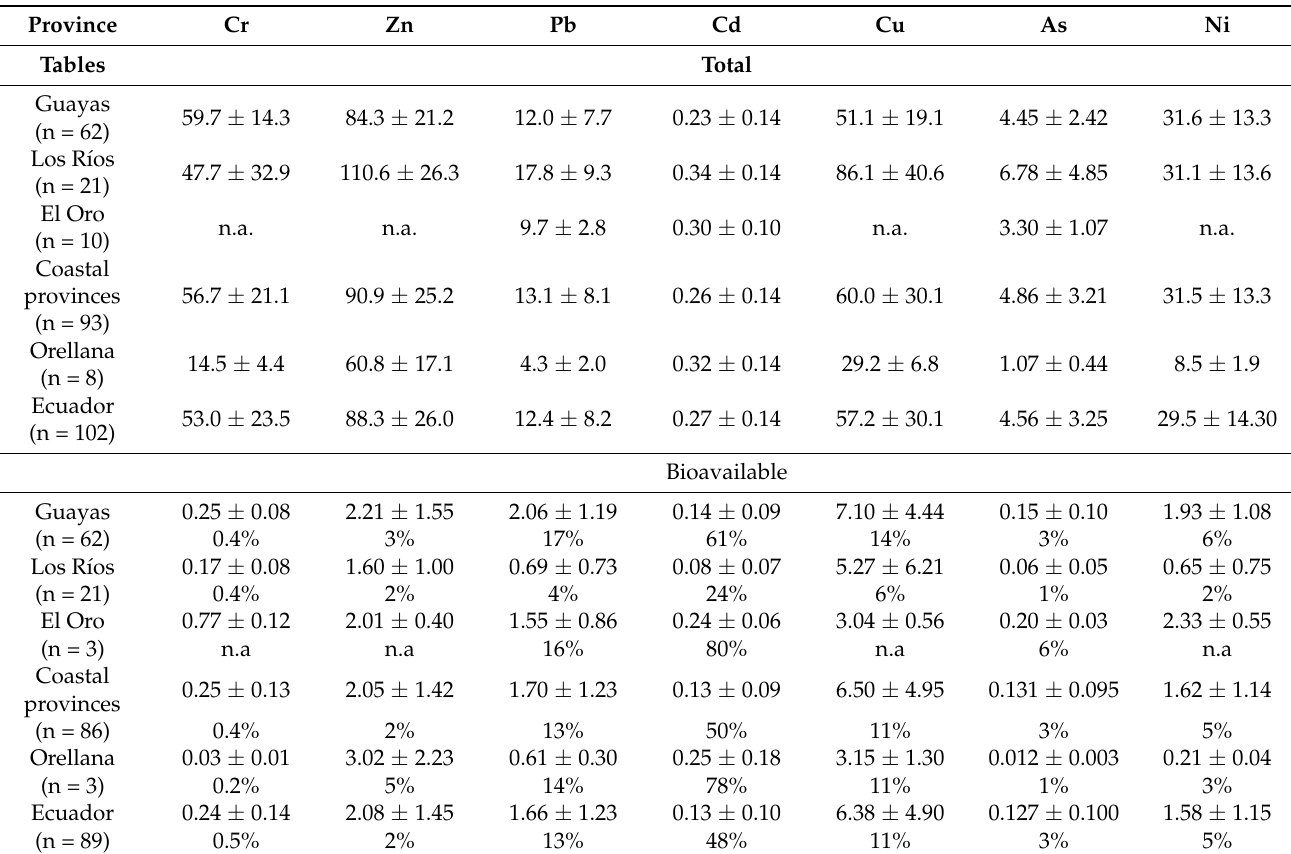
Table 2. Total and bioavailable (Mehlich) metal concentrations (mg kg − 1 ) in soil samples from rice paddies from the different provinces of Ecuador (mean ± SD). n.a.: not